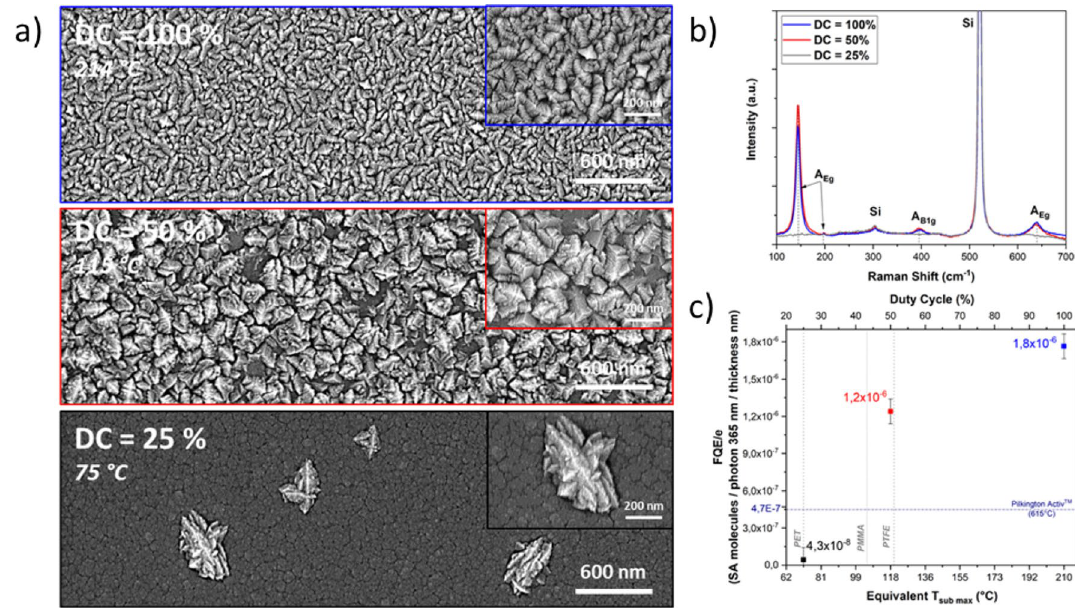
Figure 6. SEM topviews with associated T sub max ( a ), Raman scattering spectra ( b ) and Photocatalytic activity normalized to the thickness ( c ) of TiO 2 thin films deposited at different duty cycle (Power 500 W (T on ), 1 h deposition, f = 10 kHz, 25% Ar–75% O 2